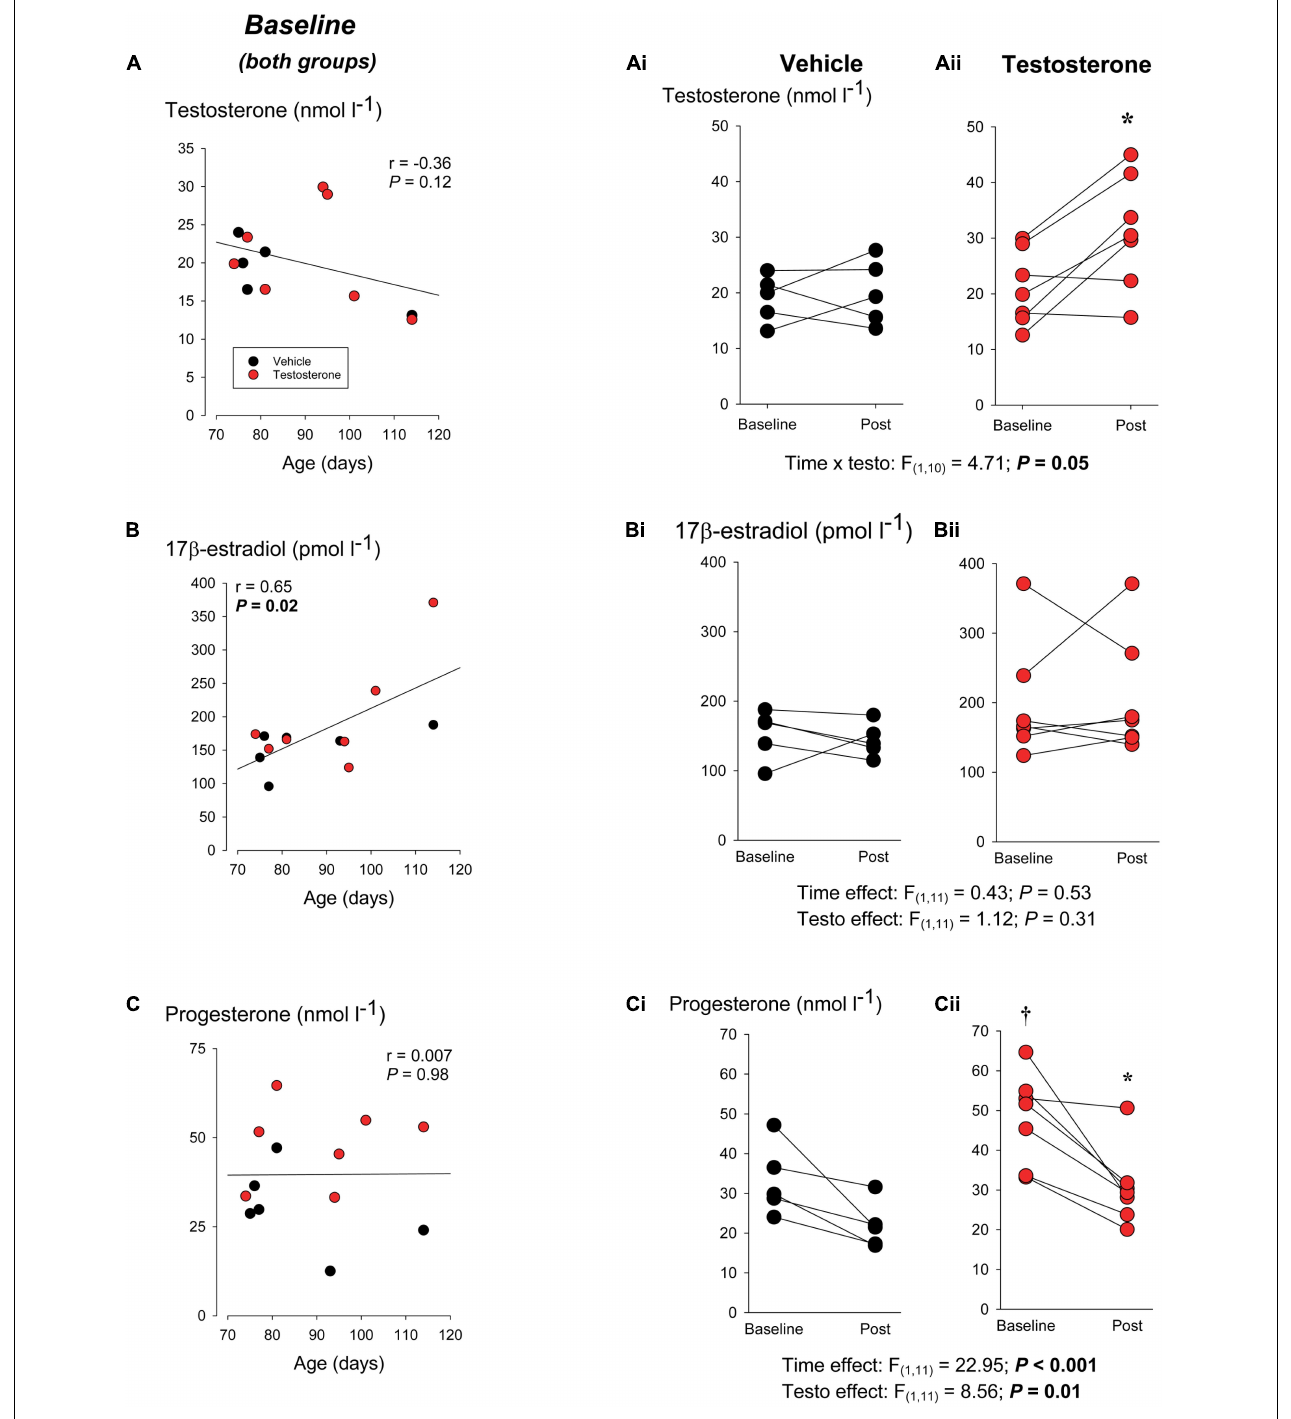
FIGURE 4 | Hormone profile of rats before and after testosterone supplementation. Left hand panels show basal levels of (A) testosterone, (B) 17 β -estradiol, and (C) progesterone across the age-range of the rats used in the first series of experiments (anesthetized rats). Blood samples were obtained from rats assigned to receive an i.p. injection of vehicle (black circles) or testosterone propionate (red circles; 2 mg/kg; i.p.). Samples were taken under basal conditions (FiO 2 = 0.30, balance N 2 ) before animals received their injection. The panels on the right show the effect of injecting (Ai,Bi,Ci) vehicle or (Aii,Bii,Cii) testosterone for each hormone. Baseline levels are the same as those reported on the left but for each animal, the “post” values were measured at the end of the protocol; i.e., after hypoxic exposure (FiO 2 = 0.12; 20 min). * indicates a value significantly different from corresponding baseline value at P < 0.05; † indicates a value significantly different from the corresponding vehicle value at P < 0.05.